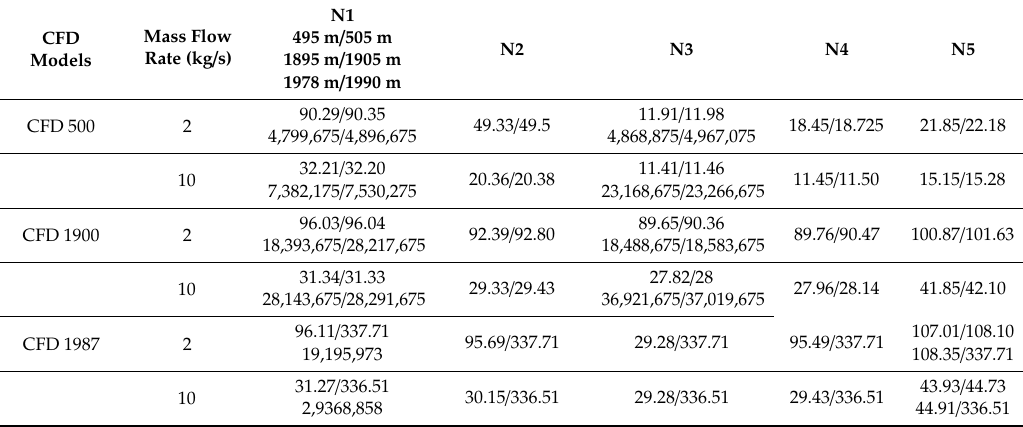
Figure 2. Schematic of the T2Well model [18] used to extract the boundary conditions applied in the 3 computational fluid dynamics techniques (CFD) models at the depth of 500 m (CFD 500), 1900 m (CFD 1900) and at the last 12 m of the deep geothermal heat exchangers (DBHE) (CFD 1987). Table 2. Temperature ( ° C) and Gauge Pressure (Pa) applied in the CFD models, extracted after 1 year of simulation from the T2Well model [18]. For the node N5 of the model CFD 1987, the values stand for the temperature at depths − 1978 m/ − 1987 m/ − 1989 m/ − 1990 m, respectively.